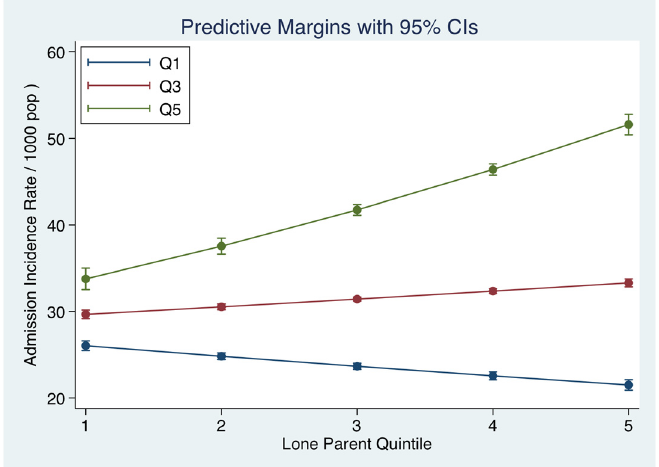
Figure 4. Interaction between small area Single Parent and unemployment rates and the Admission Incidence Rate of an emergency medical admission. The predicted probabilities were derived from the multi ‐ variable truncated Poisson model. We used margins to estimate and interpret adjusted predictions for sub ‐ groups, while controlling for other variables, using computations of average marginal effects. As the Quintiles (Q1, Q3, Q3) of unemployment increased, the strength of the association of Single ‐ Parent status with the admission rate increased.